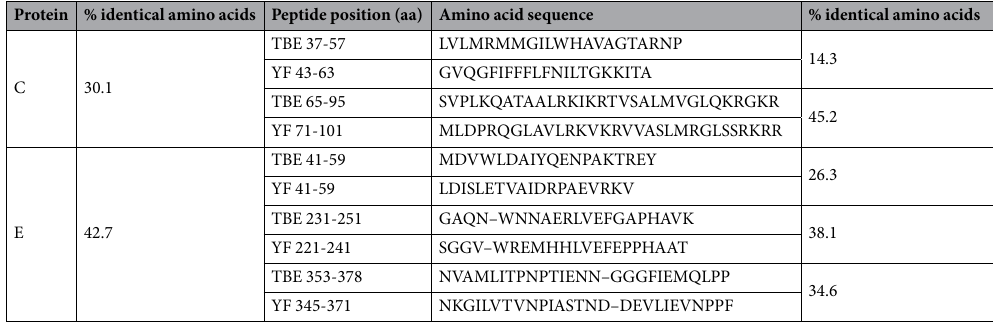
Table 1. Sequence identity between YF and TBE virus C and E proteins and congruent dominant epitope